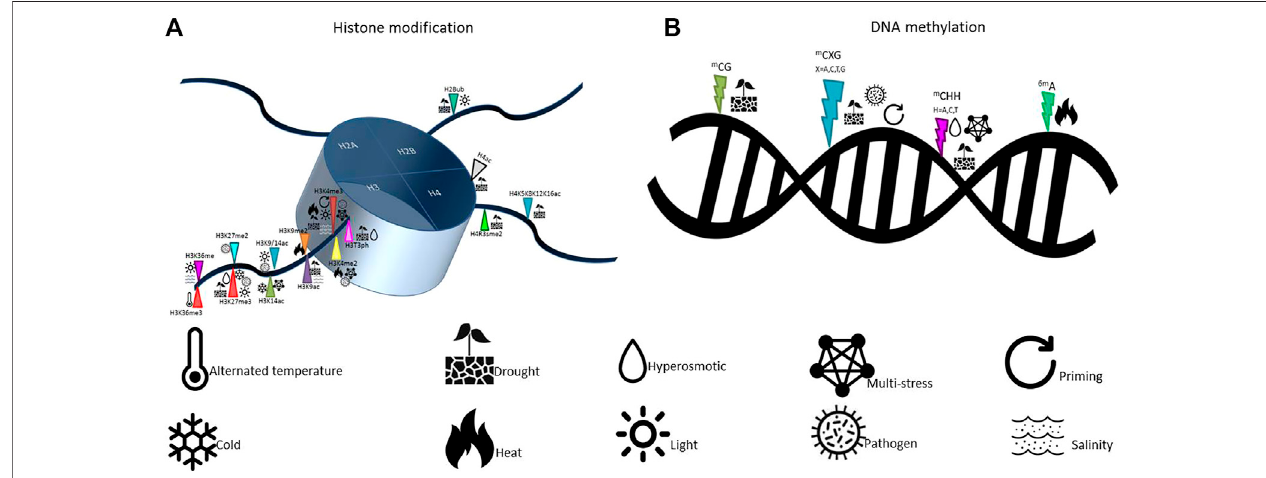
FIGURE 4 | Epigenetic mechanisms involved in plant response to stress. Histone modi fi cations (A) include acetylation/deacetyaltion and methylation/ demethylation, while DNA methylation (B) includes cytosine methylation and adenine methylation processes.